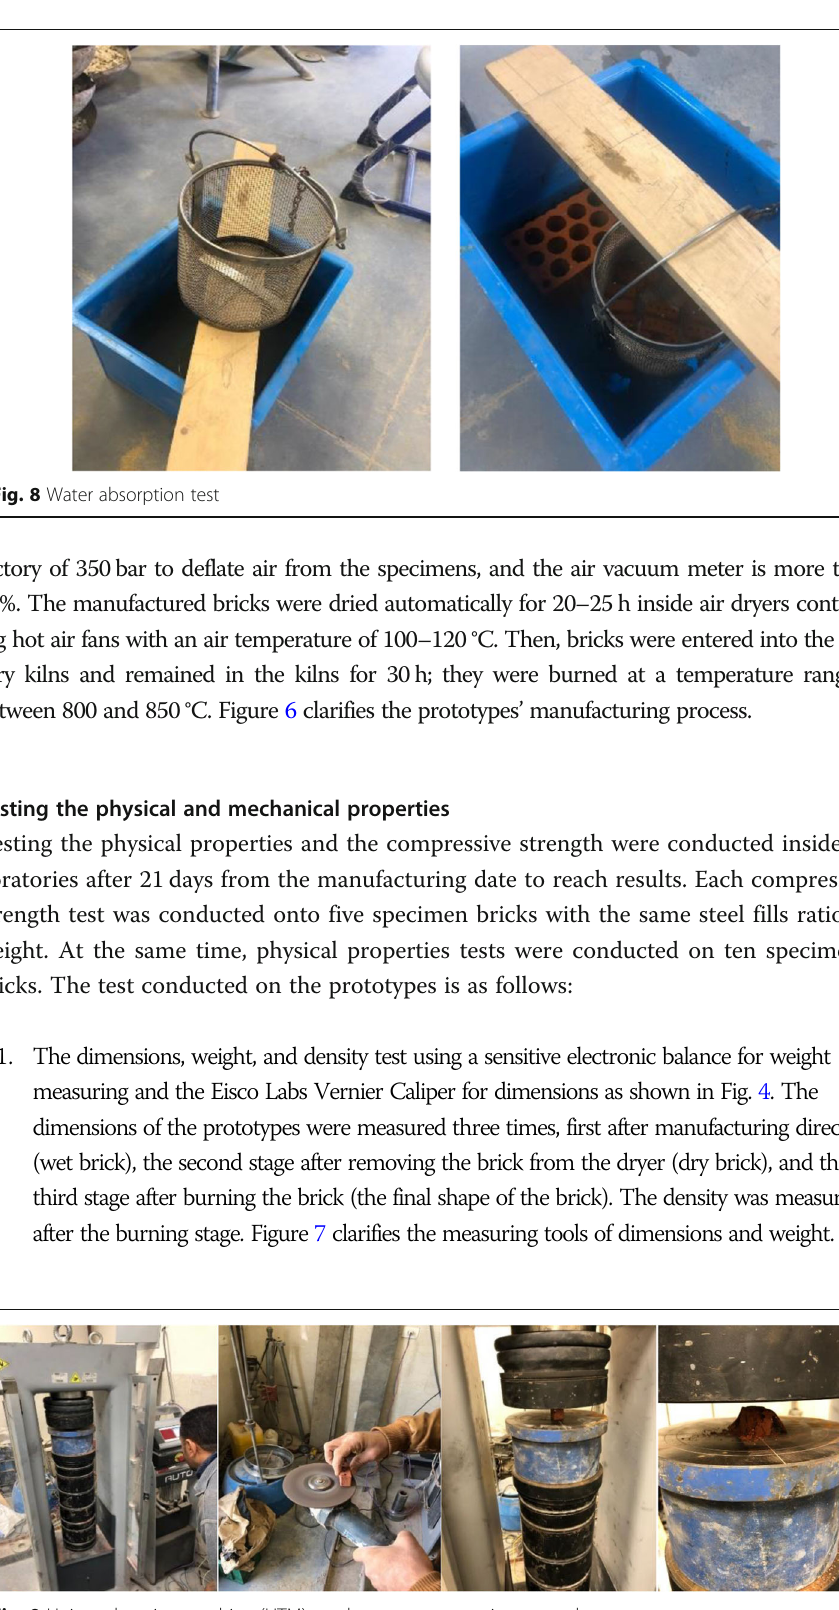
Fig. 9 Universal testing machine (UTM) used to test compressive